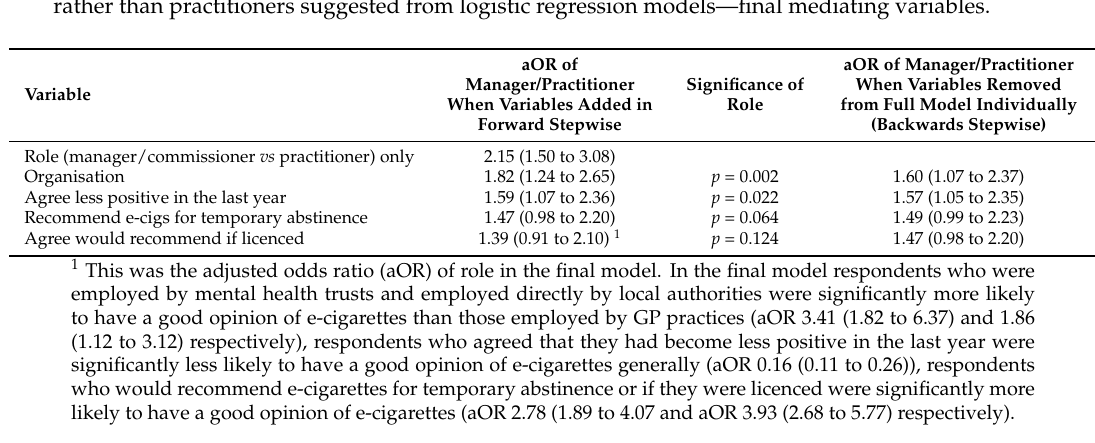
Reasons for manager/commissioners more positive view of e-cigarettes (strongly agree/agree that e-cigarettes are a good thing compared with neutral, disagree, or strongly disagree) rather than practitioners suggested from logistic regression models—final mediating